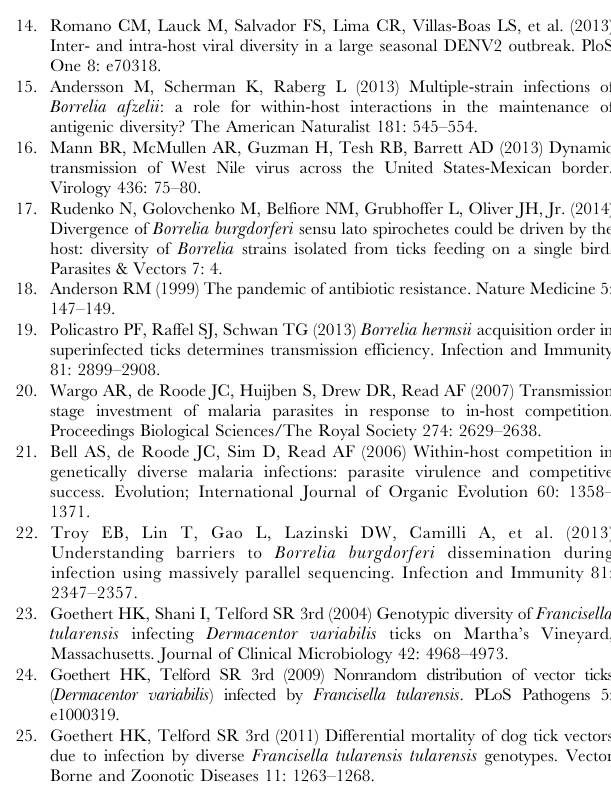
Figure S3 Recovery of individual genotypes from mice and ticks exposed to small-genotype pools. Frequency of individual genotype recovery from mice, (A) Pool C, (B) Pool D, (C) Pool E. Frequency of individual genotype recovery from ticks, (D) Pool C, (E) Pool D, (F) Pool E. The value above each graph and the red dashed line indicates the mean number of times a single genotype was recovered from mice and ticks. A significantly higher proportion of genotypes were recovered from mice compared with ticks ( x 2 = 267.0, P , 0.0001). Figure S4 Flowchart of the population model. Shown are the first two generations of the model. Lines represent feeding events and/or pathogen transfer events. To initiate the model, all pathogen genotypes are allocated to all mice. These mice are fed upon by ticks, with all ticks finding a host (not all mice are fed upon by the same number of ticks), and pathogen genotypes are acquire by feeding ticks. Infected ticks then feed on naı¨ve mice in the next generation, mixing the tick population and resulting in transmission. These mice are then fed upon by second generation naı¨ve ticks. The cycle continues for a specified number of generations. Figure S5 Retention of genotype diversity as a function of varying host and tick abundance. Number of pathogen genotypes per (A) mouse and (B) tick in simulations with varying abundances of mice and ticks. In all simulations the vector-to-host ratio was 10:1, but the number of vectors and hosts was varied. Figure S6 Retention of genotype diversity in individual mice and ticks as a function of the number of genotypes in a population. Number of pathogen genotypes per (A) mouse and (B) tick, and the